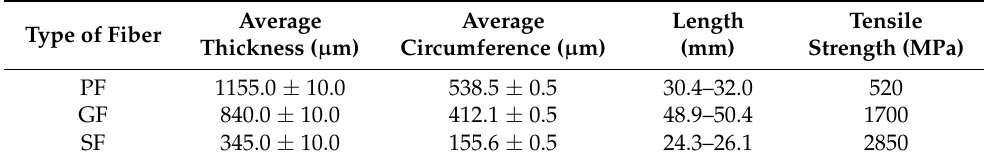
Figure 2. Recycled fibers: ( a ) polypropylene—one fiber; ( b ) polypropylene—a lot of fibers; ( c ) glass—one fiber; ( d ) glass—a lot of fibers; ( e ) steel—one fiber; ( f ) steel—a lot of fibers. Table 4. Properties of fibers.